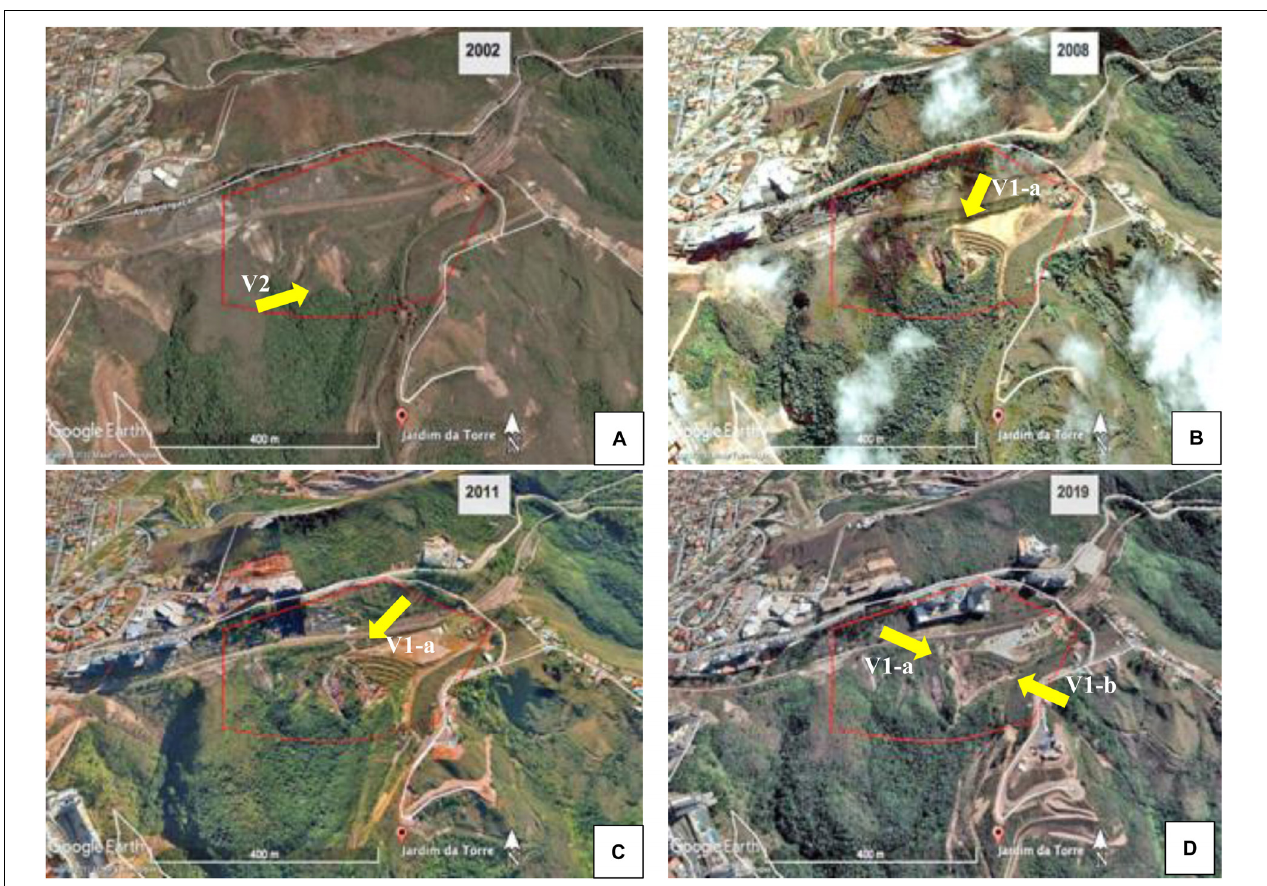
FIGURE 6 | Evolution of erosive processes in the study area, from 2002 to 2019. (A) Arrow shows the V2 gully already existing in the area in 2002; (B) arrow shows “waste landfill” built in 2008; (C) arrow shows the onset of V1 and its first incision in 2011; (D) arrow shows the V1 and its two incisions in 2019. Source: Google Earth,